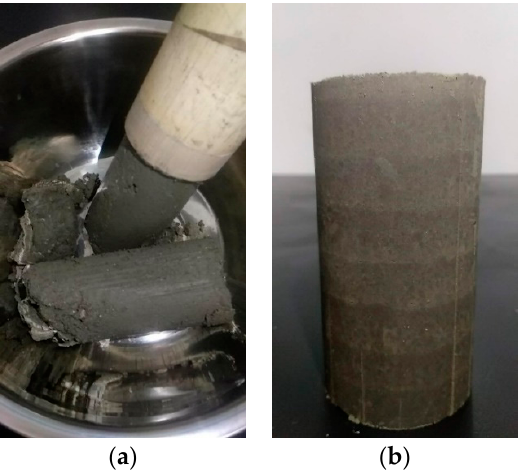
Figure 2. S-1 marine sediments: ( a ) before remolding; ( b ) after remolding.